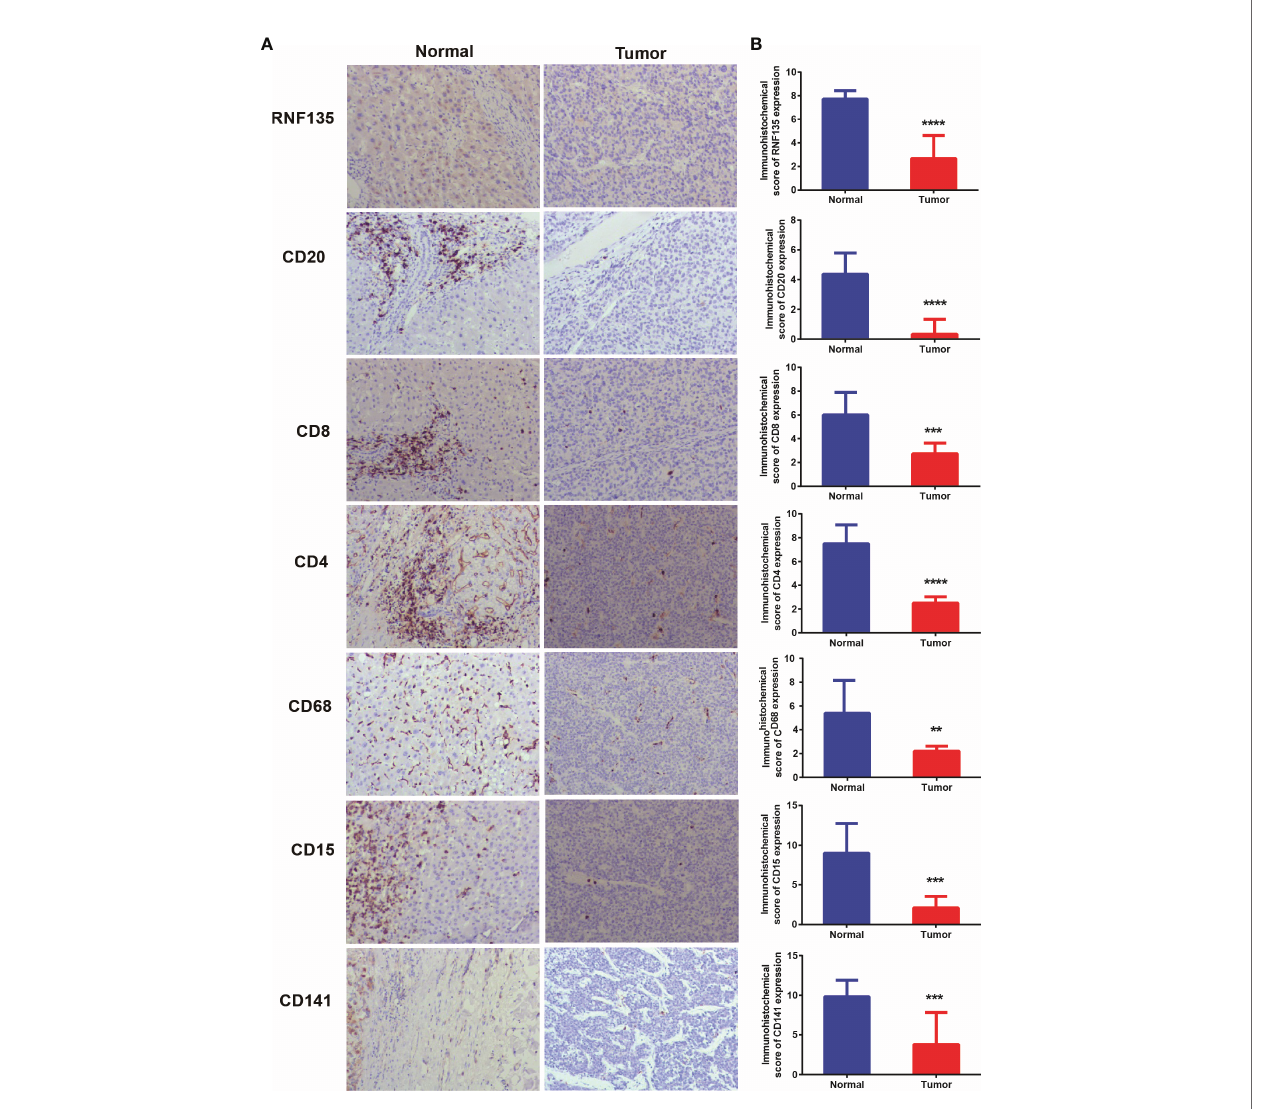
FIGURE 5 | Immunohistochemistry detected the expression of immune cells in HCC samples (A) Expression of RNF135, CD20, CD8, CD4, CD68, CD15, and CD141 in normal and HCC tissues. (B) Immunohistochemical scores of RNF135, CD20, CD8, CD4, CD68, CD15, and CD141 in normal and HCC tissues. **P ≤ 0.01, ***P ≤ 0.001, ****P ≤